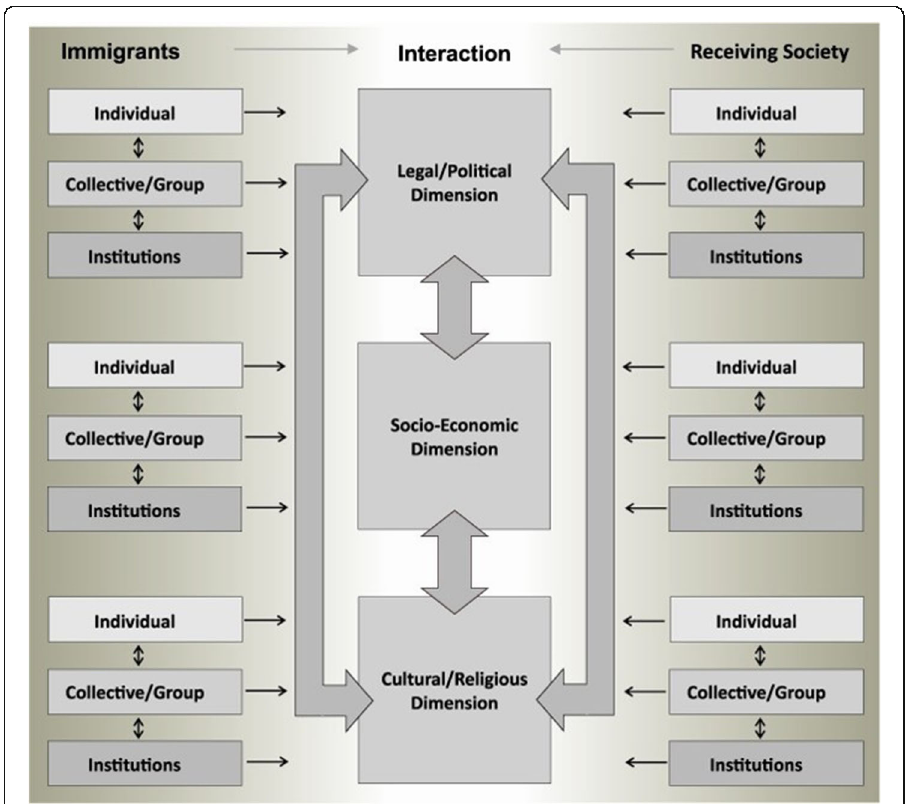
Fig. 1 A heuristic model for the empirical study of integration processes. Source: Penninx & Garcés – Mascareñas (2016, p.